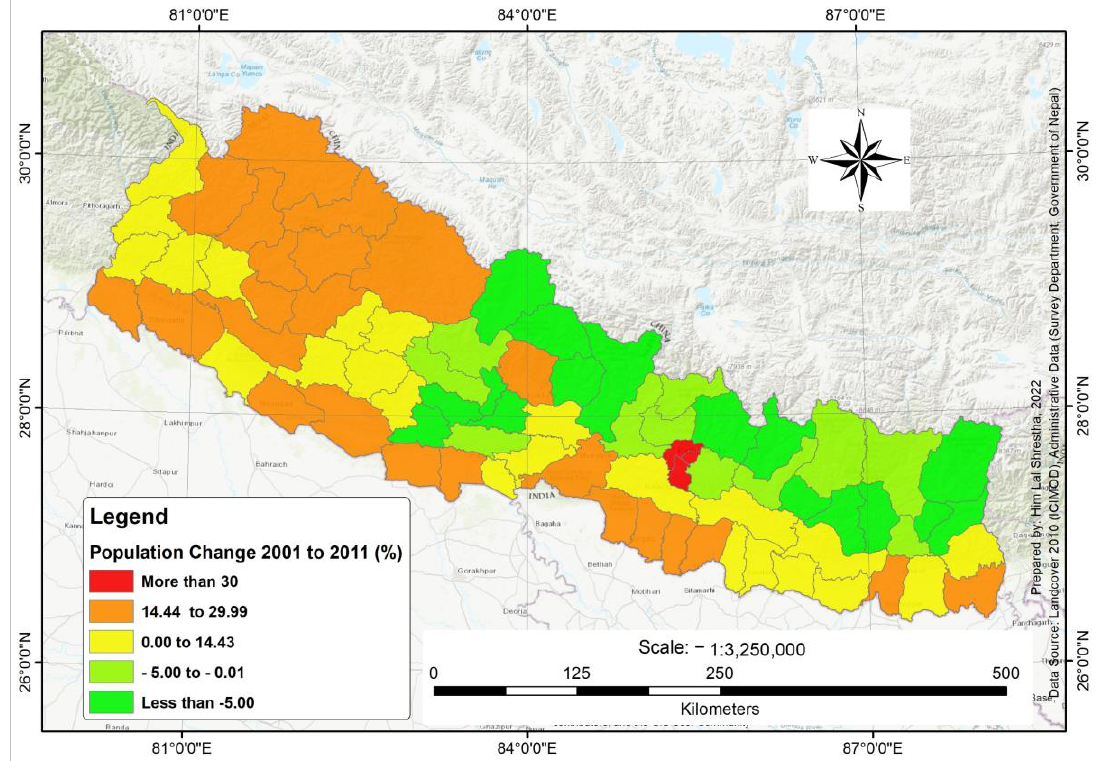
Figure 6. Nepal’s regional human population changed between 2001 and 2011 census times [Source: [122]].